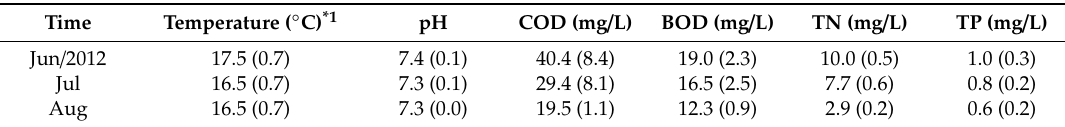
* 1 Standard deviation in brackets ( n =